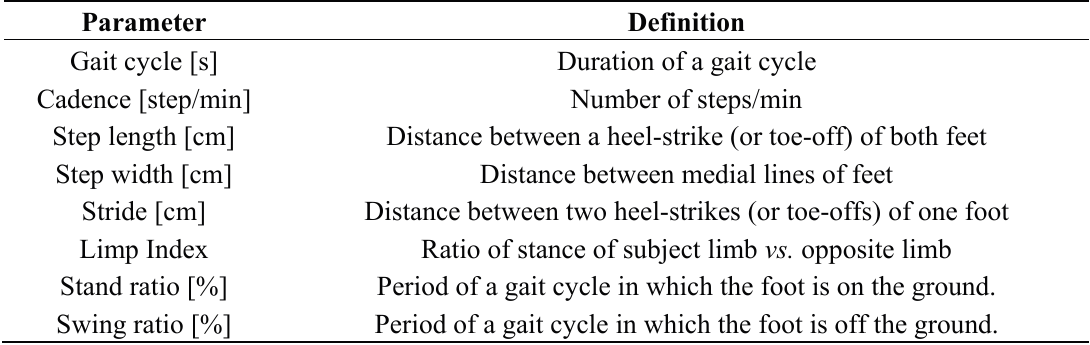
Table 1. The spatio-temporal gait parameters defined in this work.